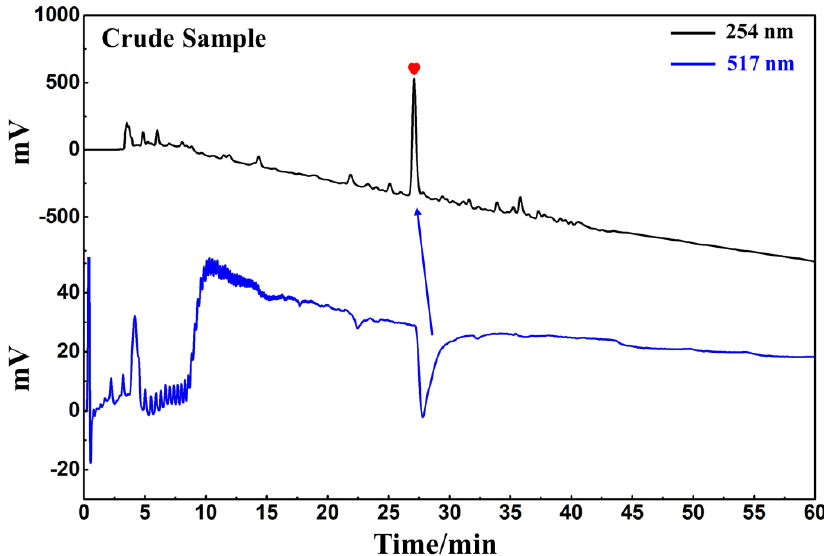
Figure 6. Analytical chromatogram on a 7-X10 analytical column and DPPH inhibitory activity profile of the extract of the ethyl acetate extraction of D. heterophyllum . Antioxidant peak marked with red heart. Conditions for HPLC1: mobile phase A: 0.1% v/v formic acid in water, B: MeOH; gradient elution: 0 – 60 min, 0 – 100% B; monitoring wavelength: 210 nm; flow rate: 1.0 mL/min; injection volume: 5 μL; column temperature: 30 °C. Conditions for HPLC2: monitoring wavelength: 517 nm; DPPH solution flow rate: 0.8 mL/min.